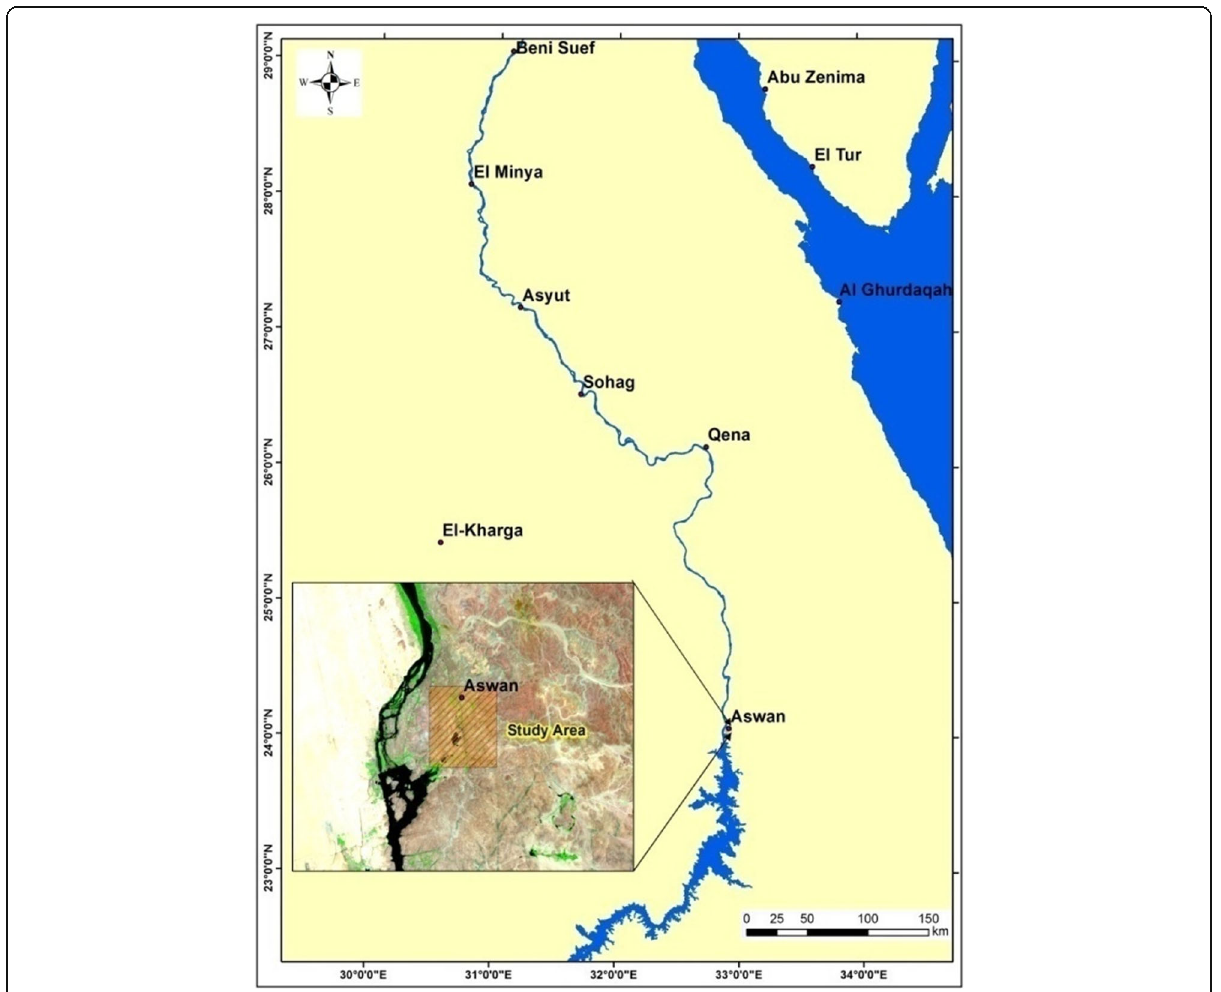
Fig. 1 Location map of the study